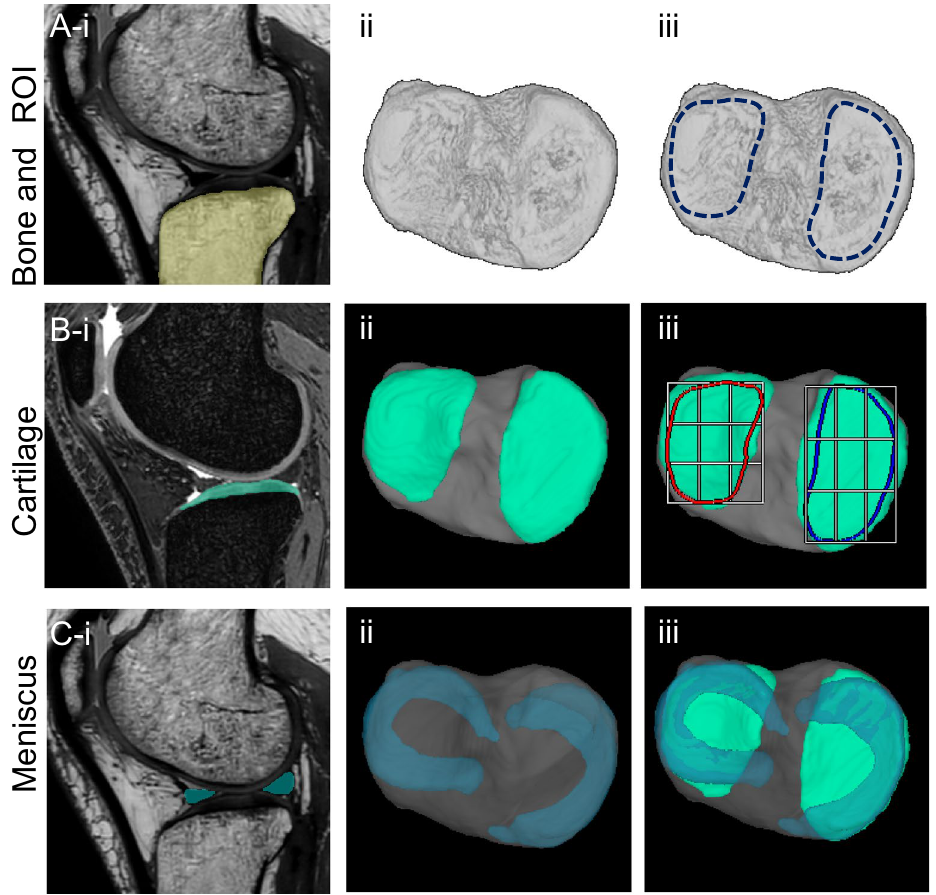
Figure 1. 3D MRI analysis of the tibial surface of a representative control knee. ( A ) Bone and ROIs. The PDW images were used for automatic segmentation of the bone region (yellow) ( i ), the 3D image was then reconstructed ( ii ), and the medial and lateral tibial articular surfaces were defined as the ROIs ( iii ). (In this image, the ROIs were drawn manually for explanatory purposes.) ( B ) Cartilage. The SPGR images were used for automatic segmentation of the cartilage region (green) ( i ), the tibial articular cartilage and bone were reconstructed in 3D ( ii ), and ROIs with nine subregions were overlapped ( iii ). ( C ) Meniscus. The PDW images were used for automatic segmentation of the meniscus regions (blue) ( i ), the medial meniscus and lateral meniscus were reconstructed in 3D and overlapped on the bone ( ii ), and the cartilage was inserted ( iii